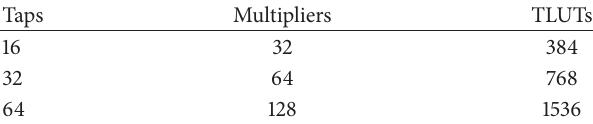
Table 3: FIR filter configurations.